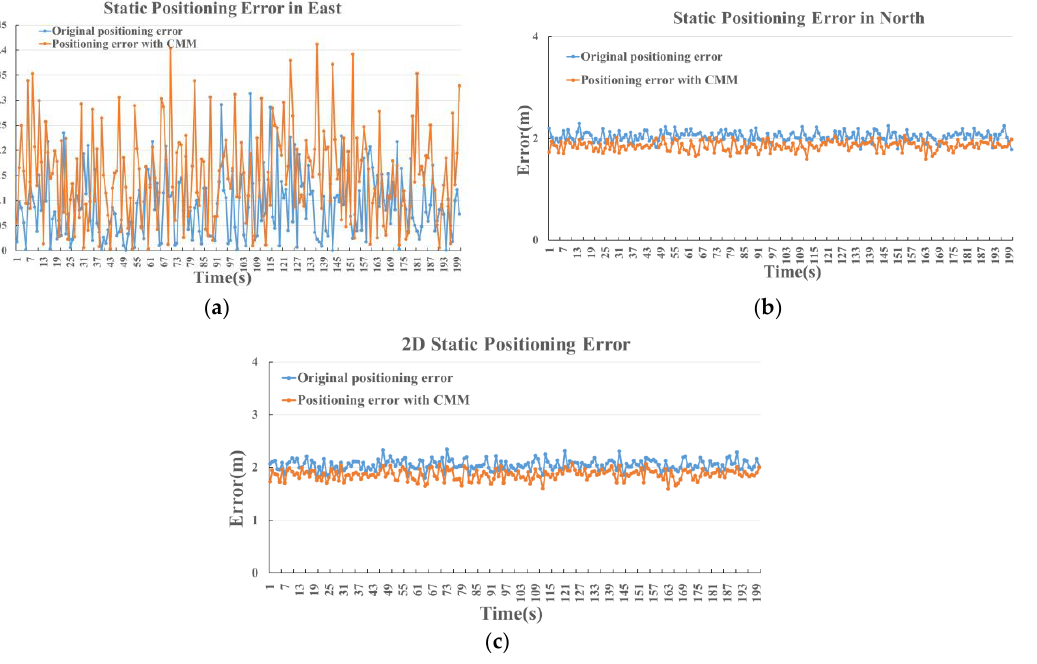
Figure 7. Static experimental results. ( a ) Eastward error; ( b ) northward error; ( c ) 2D error. Table 4. The MAE and RMSE of static positioning experimental results.